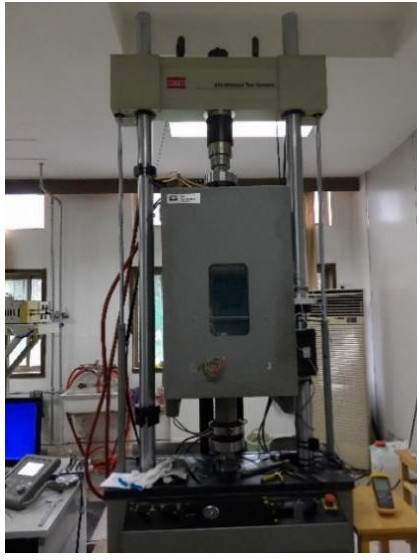
Figure 6. MTS810 material experimental system. Table 2. ZK60 magnesium alloy chemical composition (%).